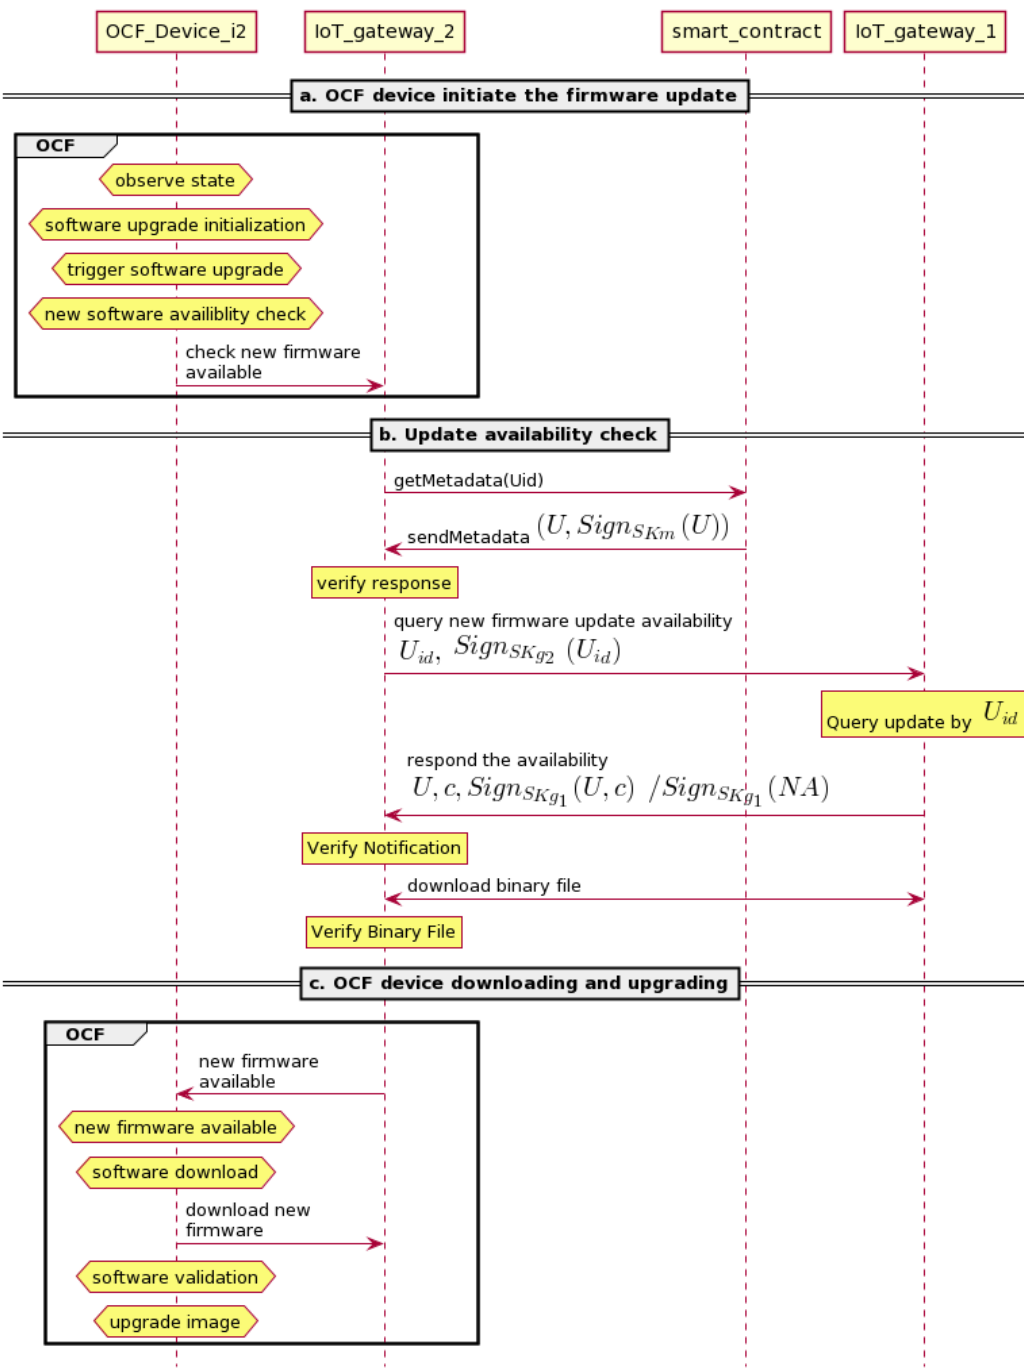
Figure 5. Peer-to-peer firmware update distribution: gateway downloading a new firmware update from another